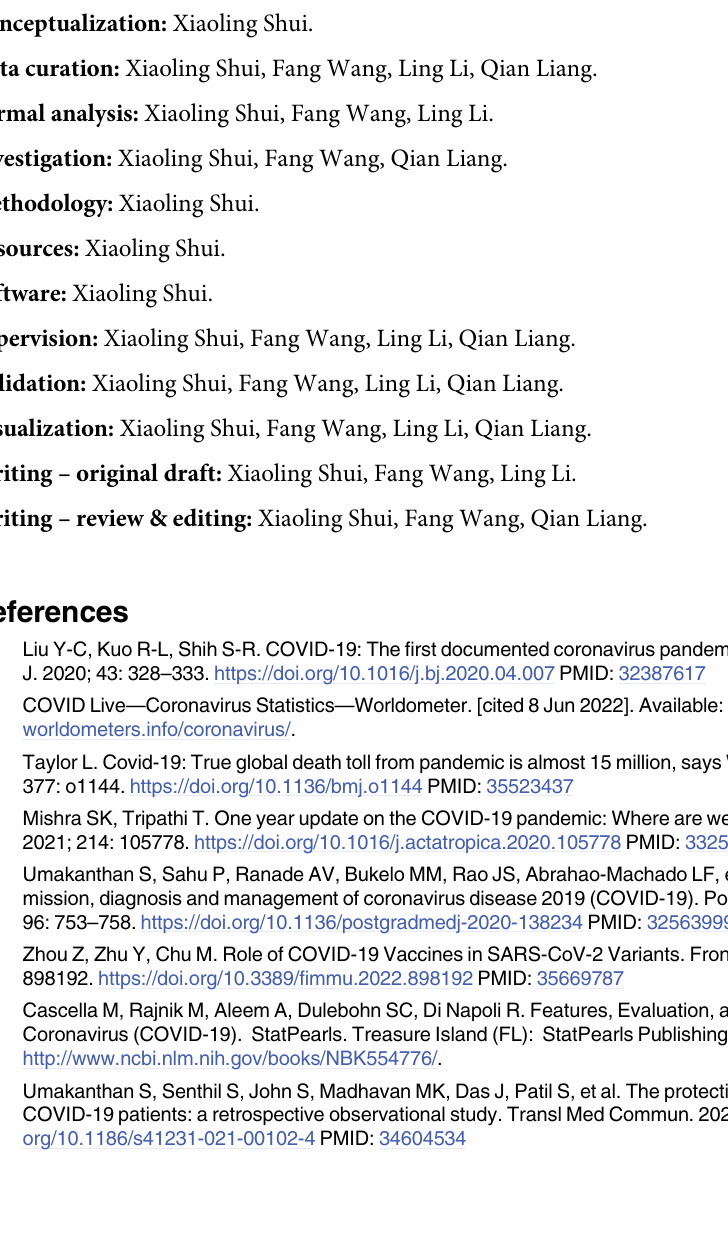
S2 Table. Search string for PubMed. S3 Table. ARHQ methodology checklist for cross-sectional/prevalence study. S4 Table. Quality evaluation of the 18 studies included in the meta-analysis. S5 Table. Leave one out sensitivity analysis of pooled COVID-19 vaccine acceptance rate among HCWs in